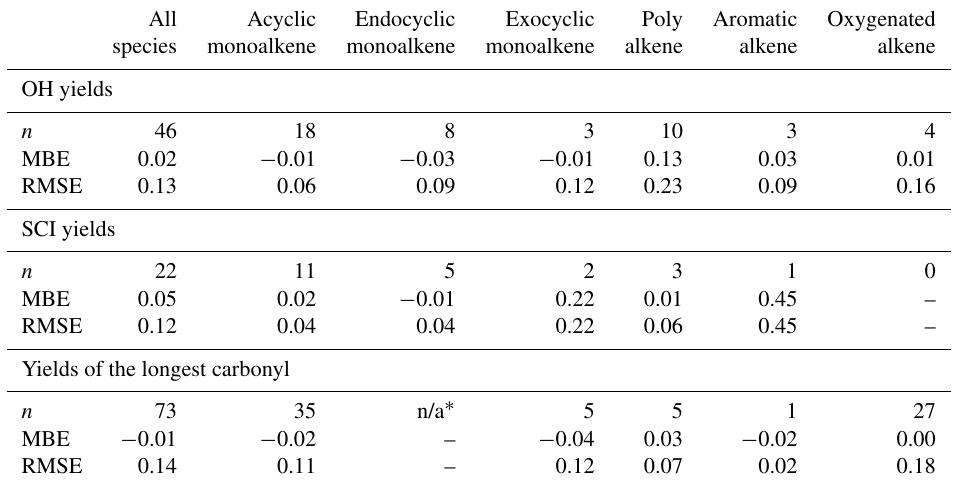
Table 4. Number of species ( n ) in the database used to compute the mean bias error (MBE) and the root mean square error (RMSE) for the OH yields, SCI yields and “longest” carbonyl yield. not applicable –